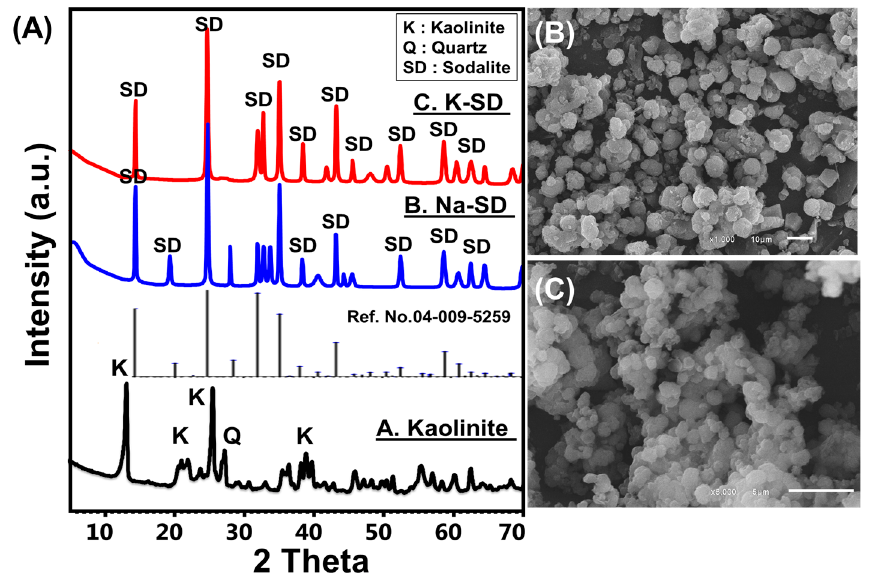
Figure 1. XRD patterns of kaolinite and the synthetic sodalite phases ( A ), SEM image of Na-sodalite (Na.SD) ( B ), and SEM image of K-sodalite (K.SD) ( C ). (Na.SD) ( B ), and SEM image of K-sodalite (K.SD) ( C